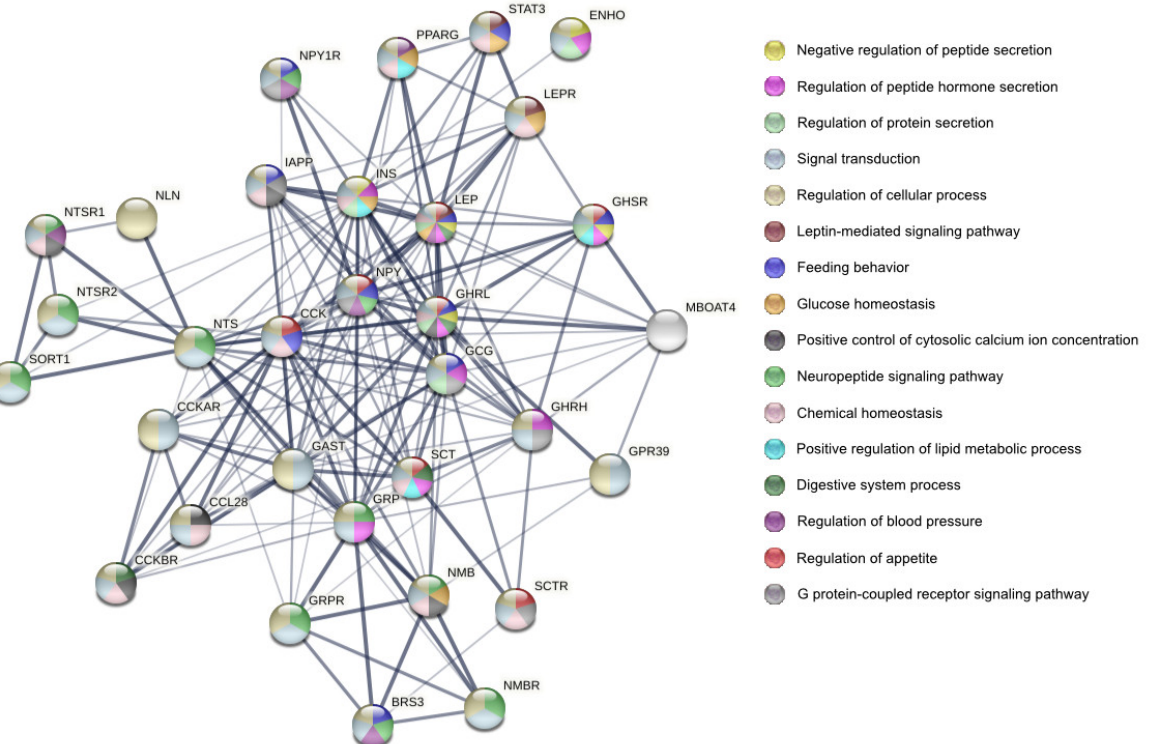
Figure 1. STRING protein–protein interaction diagram in various biological processes involving adropin (ENHO) and many other hormones and growth factors. The thickest edge indicates the highest confidence in protein–protein association. Network contains 32 nodes and 171 edges. The analysis of biological effects revealed that the proteins presented here are involved in many biological functions within the organism; https://string-db.org/, accessed on 25 August 2022. The proteins are described in Supplementary Materials.